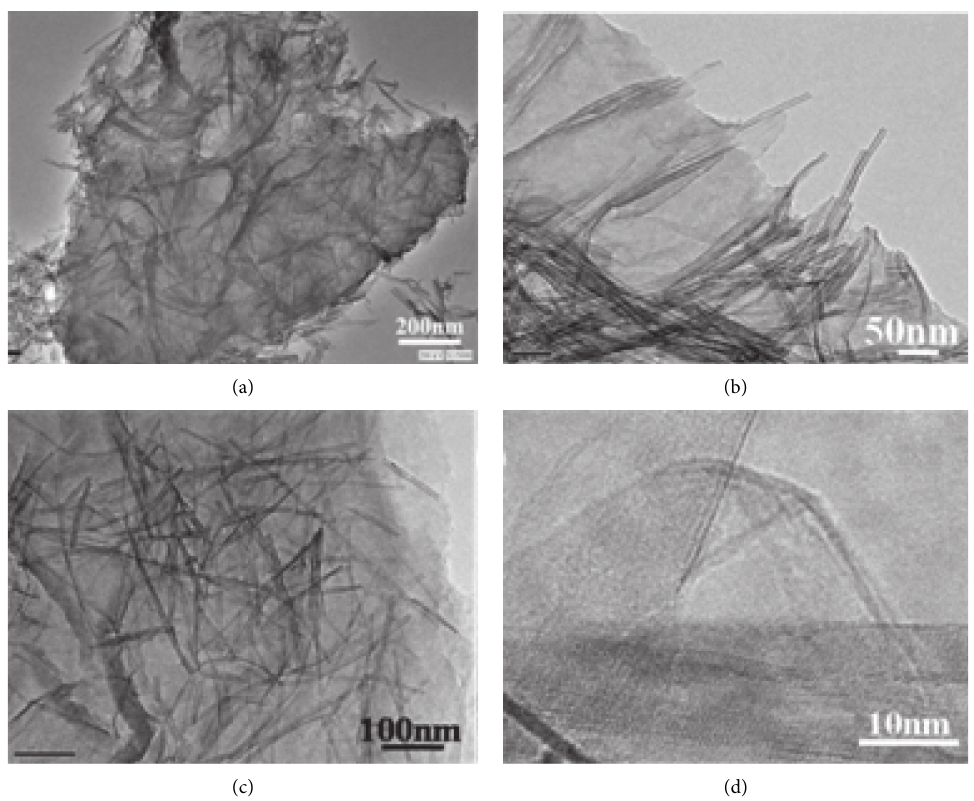
Figure 2: (a) The low-magnification TEM image of GTNT composite. (b)-(c) The enlarged TEM images of the GTNT composite. (d) The high-resolution TEM image of the GTNT composite.